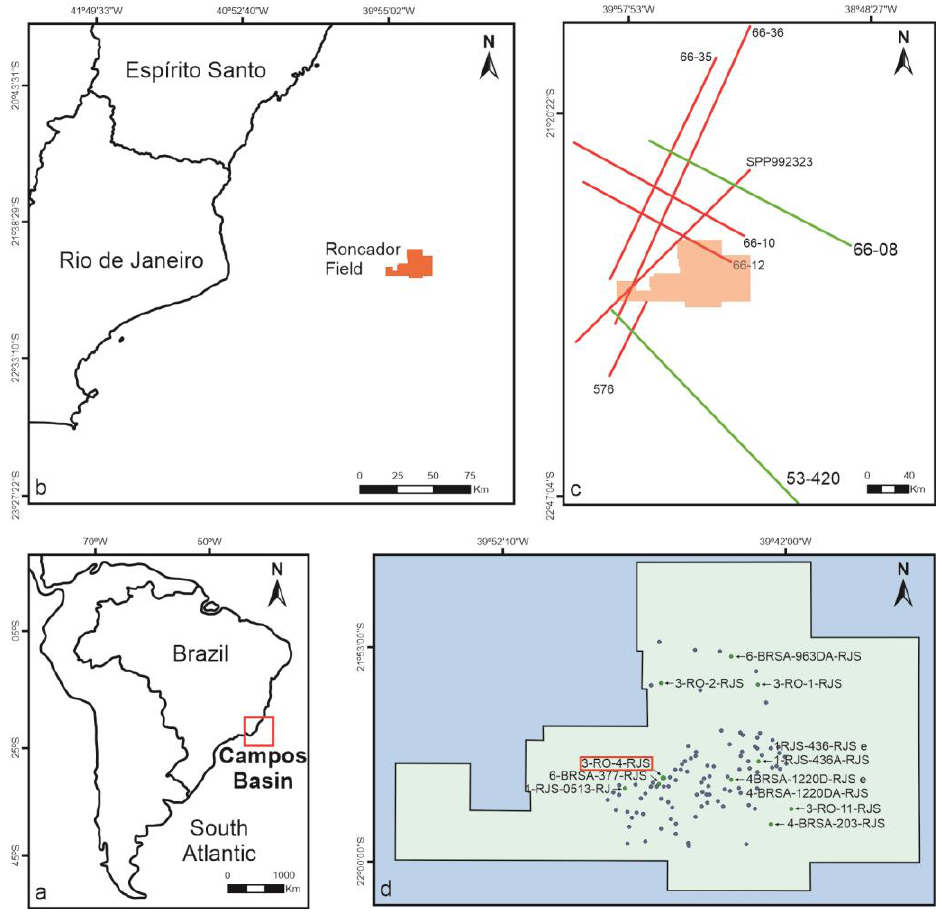
Figure 6. Map of Brazil ( a ); Roncador field on the Campos Basin ( b ) adapted from Furlan [13]; location of the 2D seismic lines 66-08 and 53-420 ( c ) adapted from Furlan [13]; location of wells in the Roncador field (blue dots), of the analyzed wells (green dots) and of the well 3-RO-4-RJS (inside the red rectangle), selected to be presented in the results ( d ) adapted from Ref.